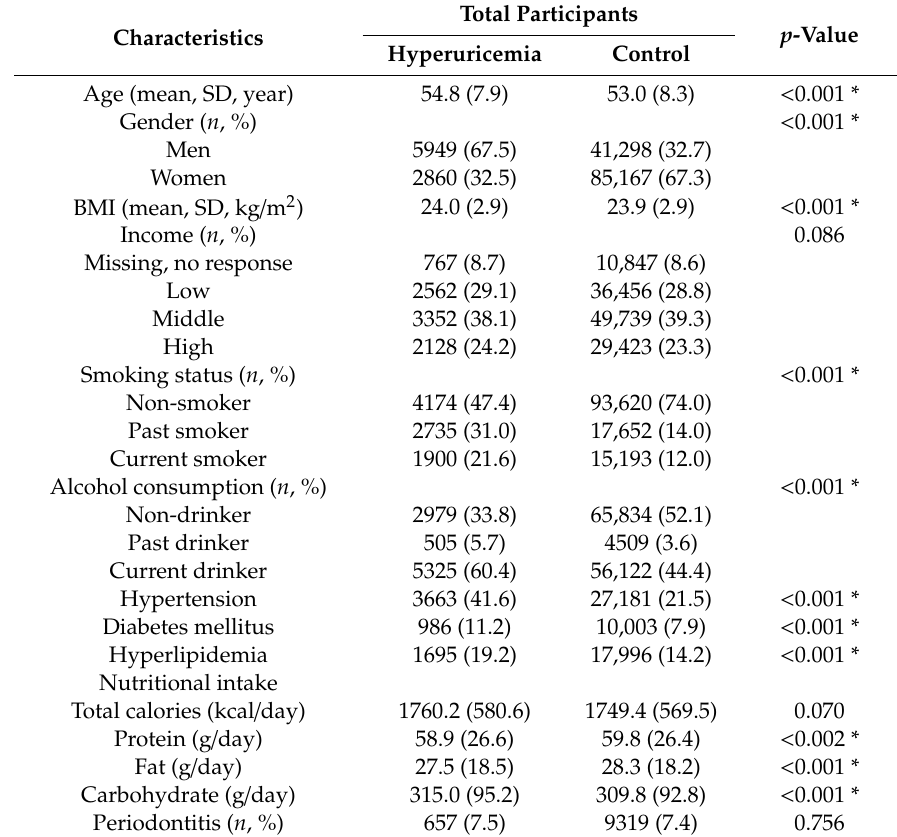
Table 1. General characteristics of